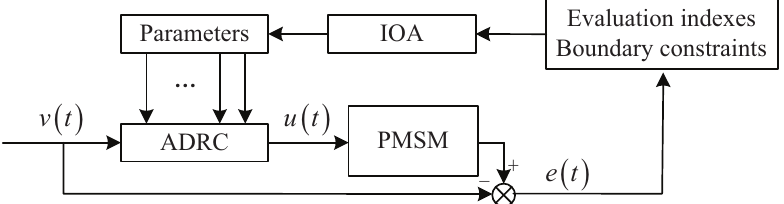
Figure 3. Diagram about theADRC parameters adjusting method using intelligentoptimization